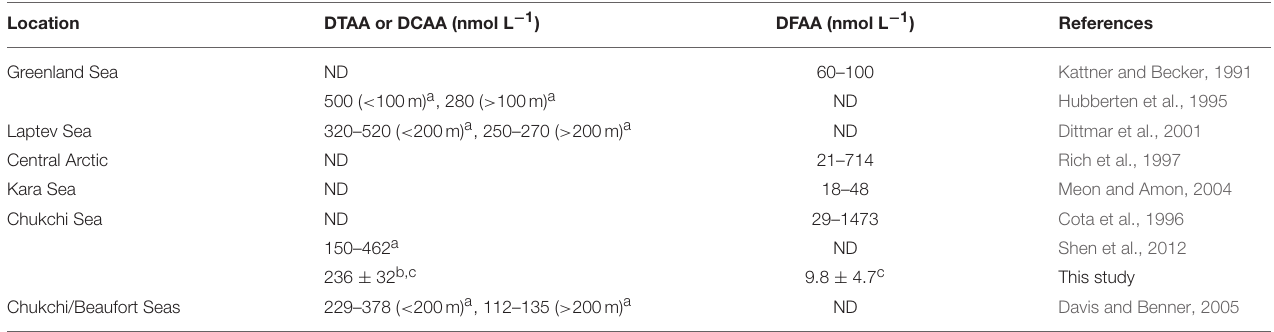
TABLE 4 | Concentrations of dissolved combined amino acid (DCAA), dissolved free amino acid (DFAA), and dissolved total amino acid (DTAA) in the Arctic Ocean.